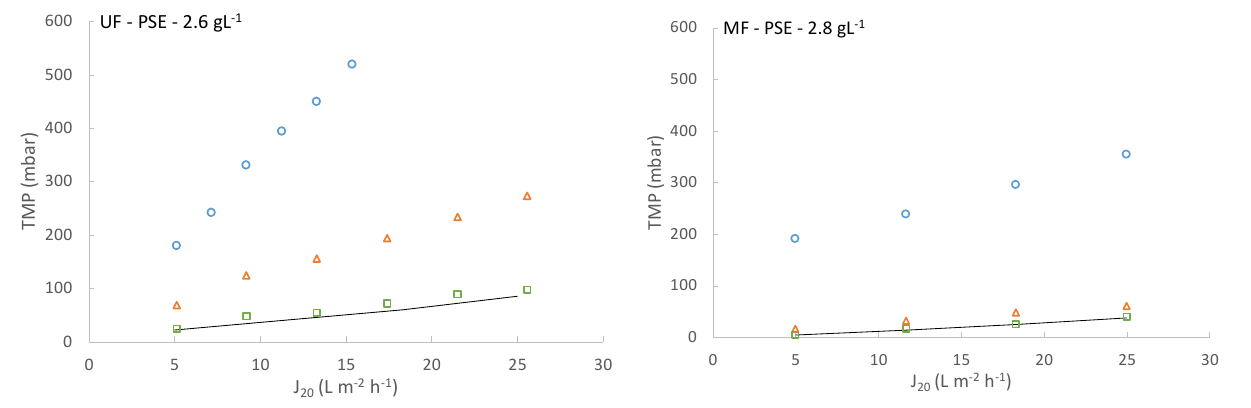
Figure 6. Membrane permeability recovery after the chemical cleaning. Note that the legend shows the membrane used, influent treated and average total suspended solids concentration of each operating period before the chemical cleaning. Tap water was used in all cases for determining the membrane resistance ― original membrane resistance; membrane resistance after the operating period; membrane resistance after the basic cleaning; membrane resistance after the acid cleaning. Raw: influent municipal wastewater after a classic pre-treatment (screening and sieving, desanding and degreasing). PSE: effluent of the full-scale wastewater treatment plant primary set- tler.